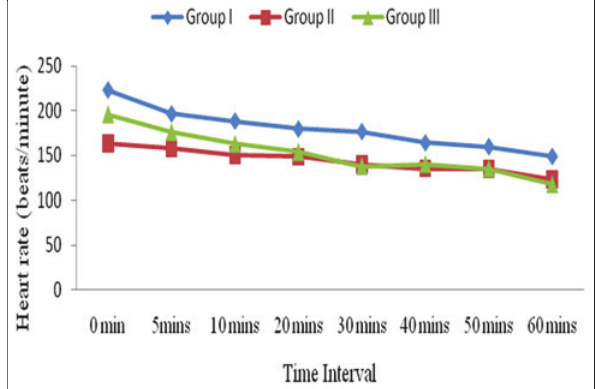
Figure-2: Mean heart rate (beats/min) in birds of different groups.